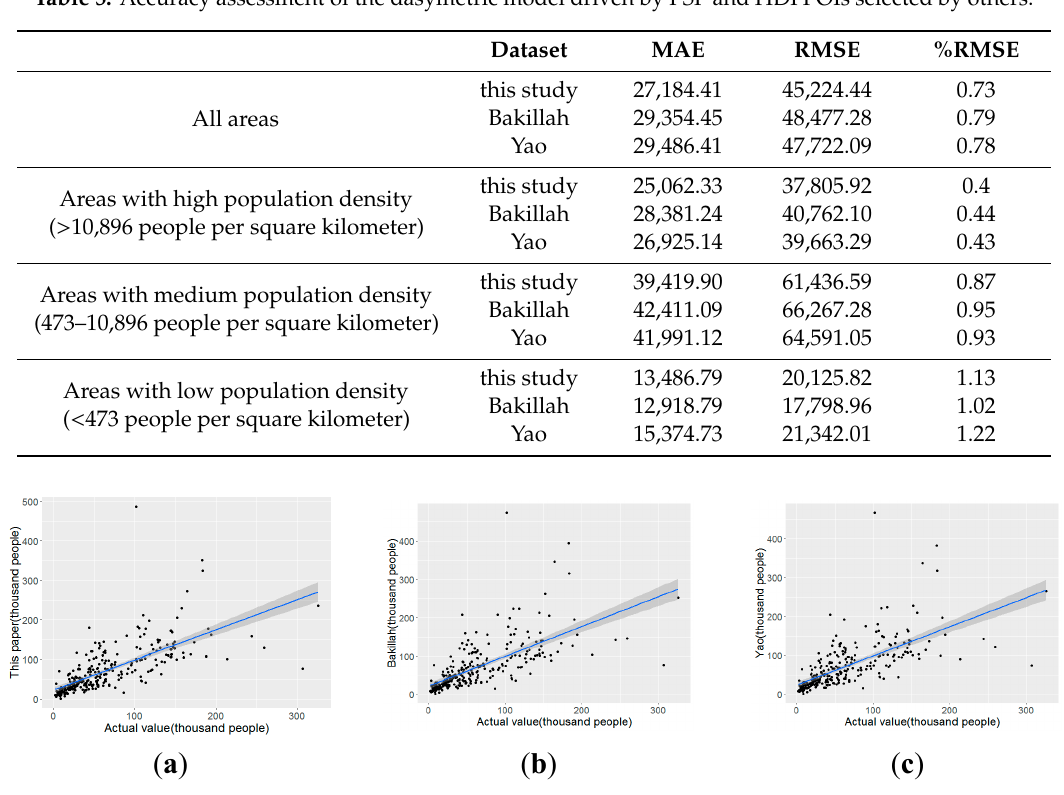
Figure 11. Scatter plots of dasymetric model driven by PSP and HDI POI select by others ( a ) PSP ( b ) Bakillah ( c ) Yao.